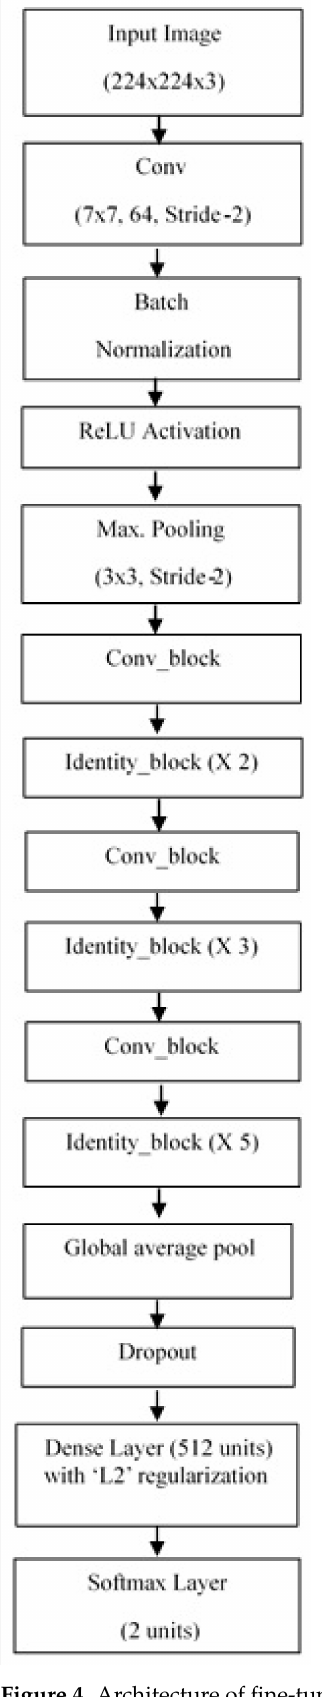
Figure 4. Architecture of fine-tuned ResNet50V2